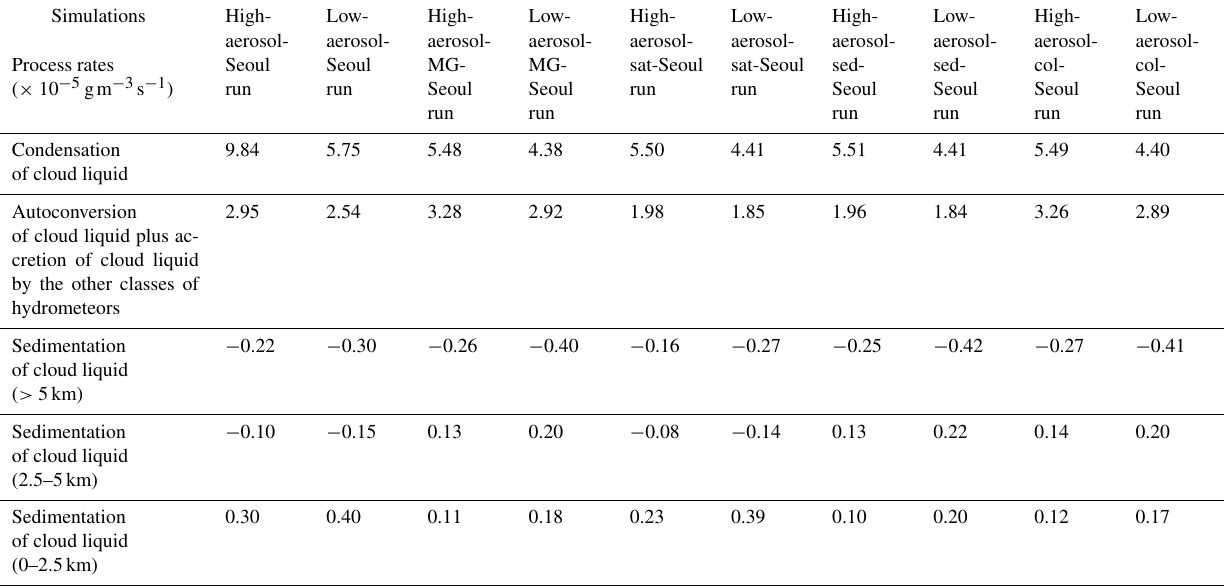
Table 2. Rates of the different processes that are associated with saturation, collection, and sedimentation for the Seoul case. The cloud liquid condensation and collection (i.e., autoconversion plus accretion of cloud liquid) rates as shown here are averaged over the whole domain and simulation period. The sedimentation rates as shown here are averaged over the whole simulation period and over each of the following three layers with different altitude ranges: a layer between the surface and 2.5km, between 2.5 and 5.0km, and above 5.0km. Simulations